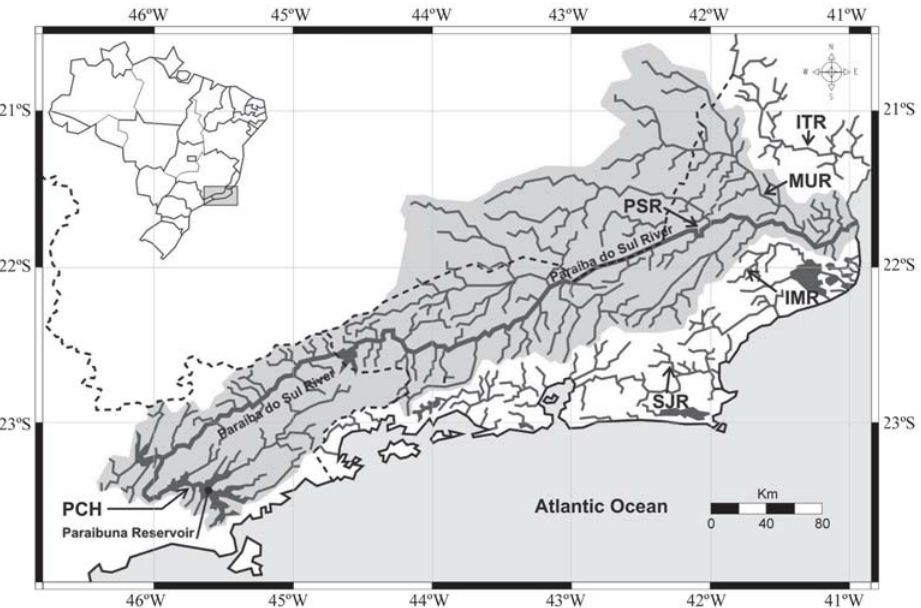
Fig. 1. Location of sampling sites of Brycon insignis in drainages in Southeastern Brazil. Power Company Hatchery (PCH), São João River (SJR), Paraíba do Sul River (PSR), Imbé River (IMR), Muriaé River (MUR) and Itabapoana River